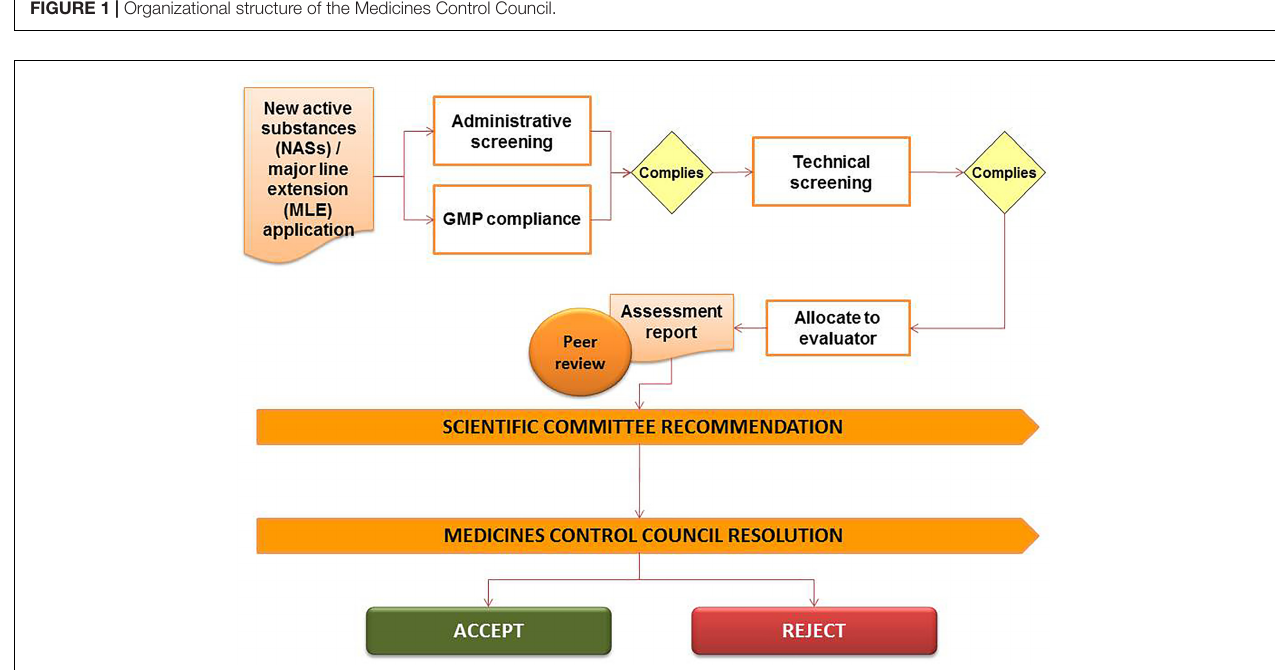
FIGURE 1 | Organizational structure of the Medicines Control Council.